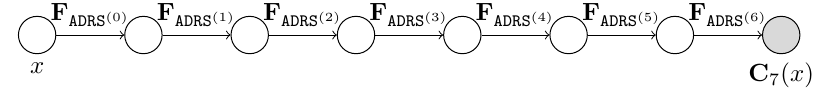
Figure 2: The chaining pseudorandom